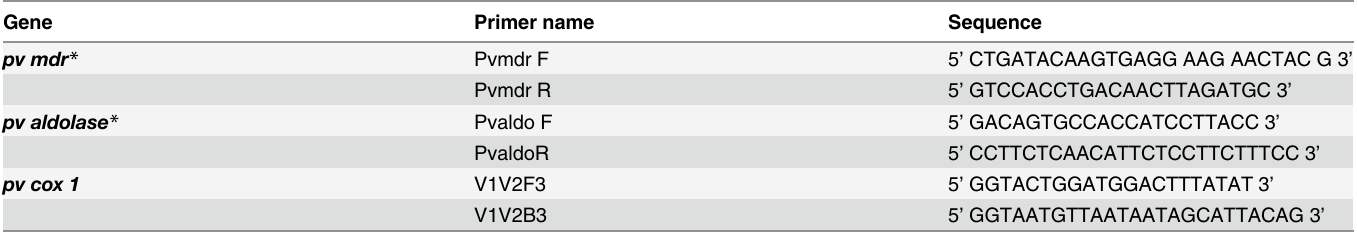
Table 1. Primers used to amplify Pv mdr, aldolase and cox 1 ( * Source [36]).